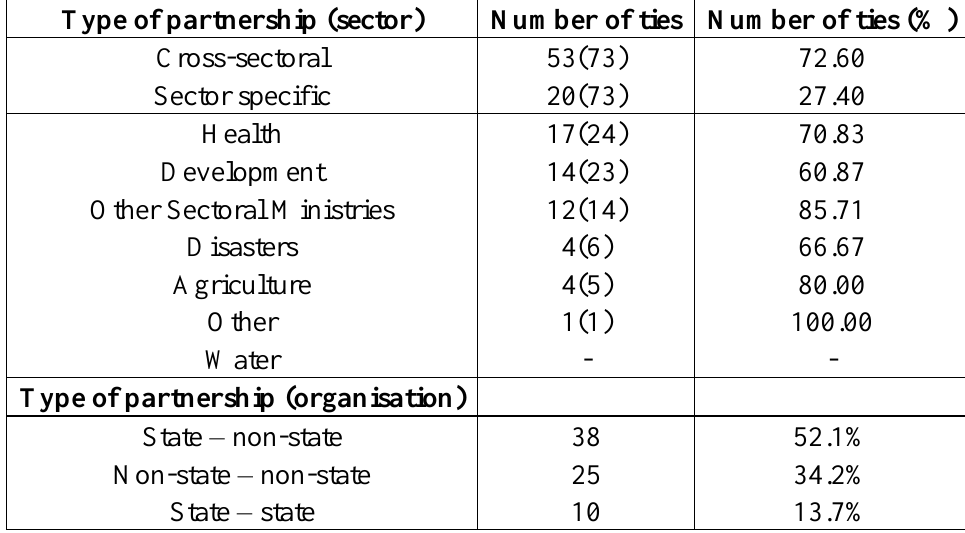
Table 4. Ties between different sectors and types of organizations.